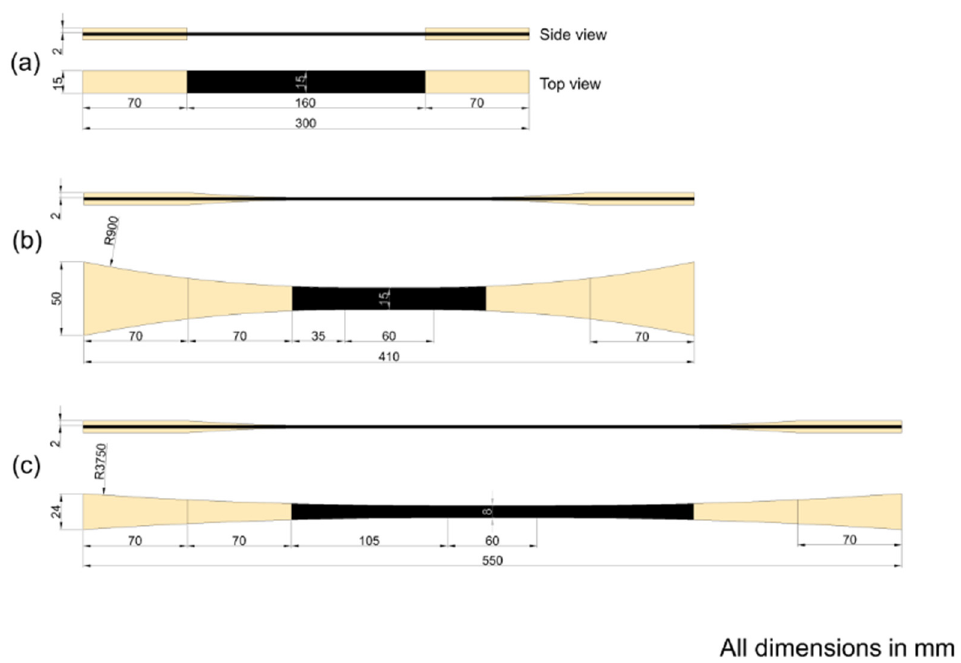
Figure 1. Unprotected test specimens; geometry and dimensions: ( a ) straight-sided, ( b ) butterfly, ( c ) X-butterfly.